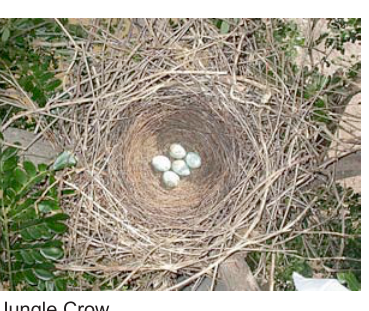
Image 1. Nest and eggs of bird’s species recorded in the study